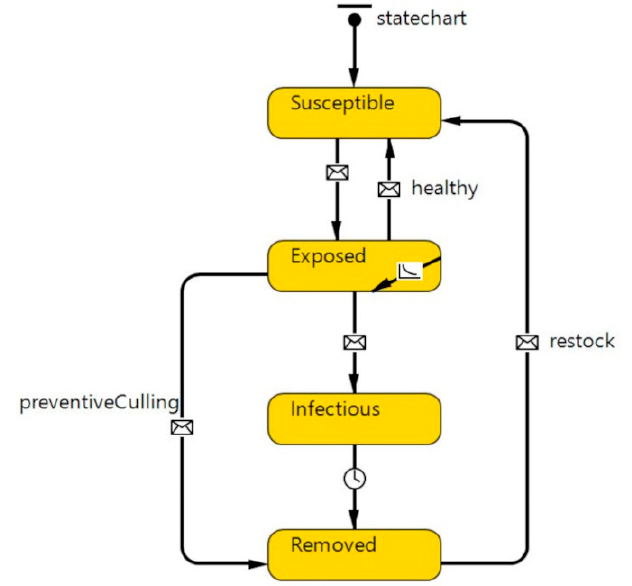
Figure 3. Statechart of the SEIR model on an individual pig holding level.